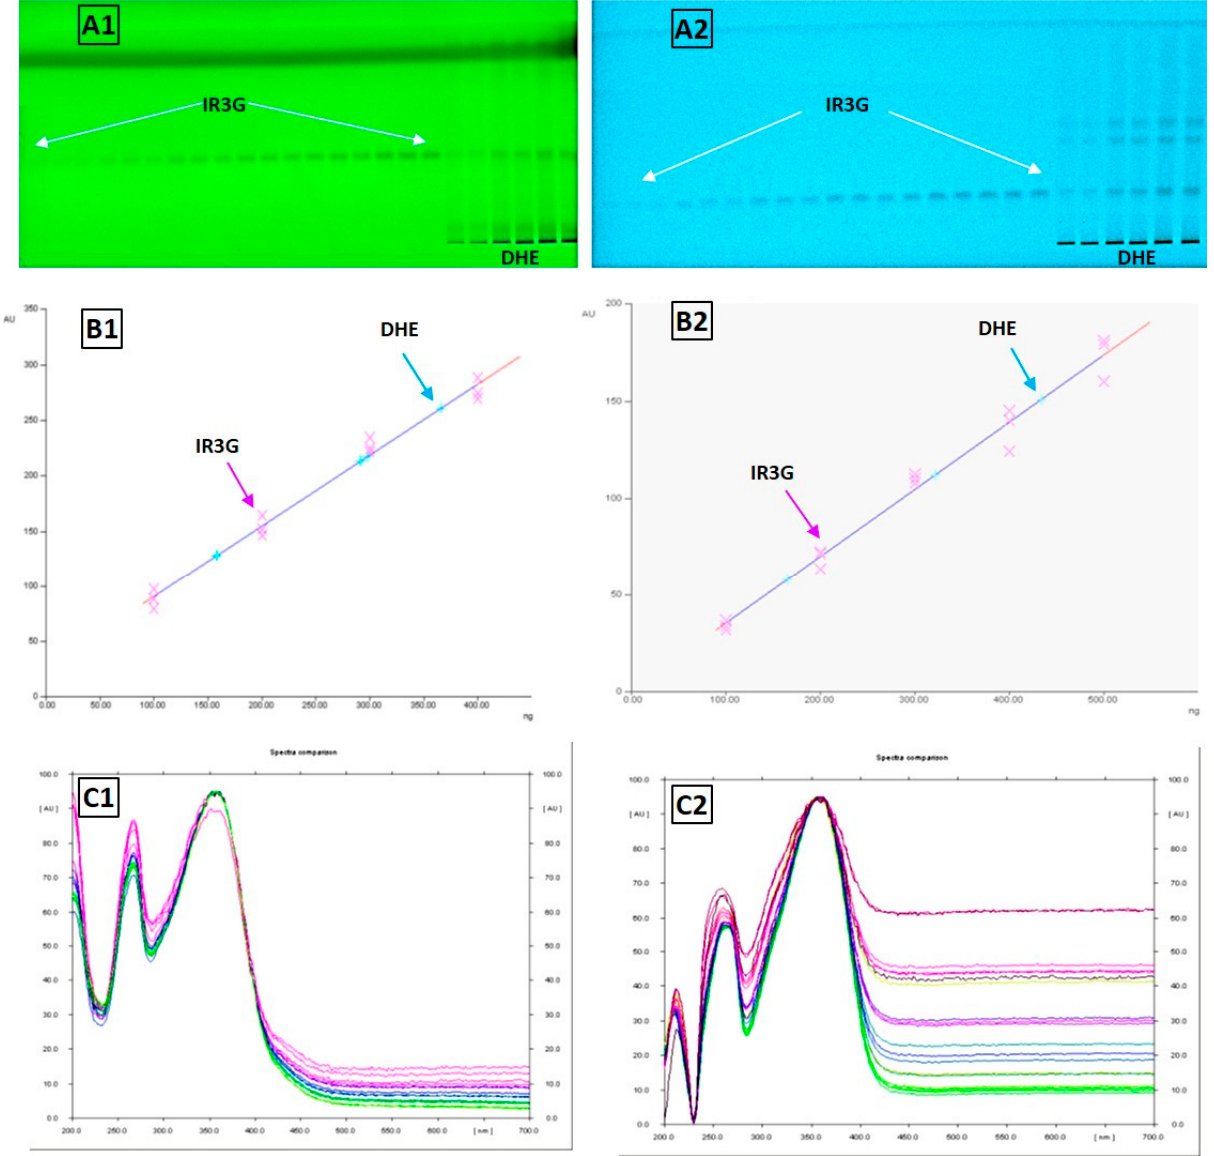
Figure 10. HPTLC analysis of IR3G and DHE. Chromatograms of IR3G and DHE detected on NP ‐ ( A1 ) and RP ‐ HPTLC ( A2 ) by UV 254 nm. Calibration plots based on UV absorbance at 254 nm against different concentrations (ng) of IR3G and DHE in NP ‐ ( B1 ) and RP ‐ HPTLC ( B2 ). Overlay UV spectra ( λ 200–700 nm) of standard IR3G and IR3G in DHE, in NP ‐ ( C1 ) and RP ‐ HPTLC ( C2 ).